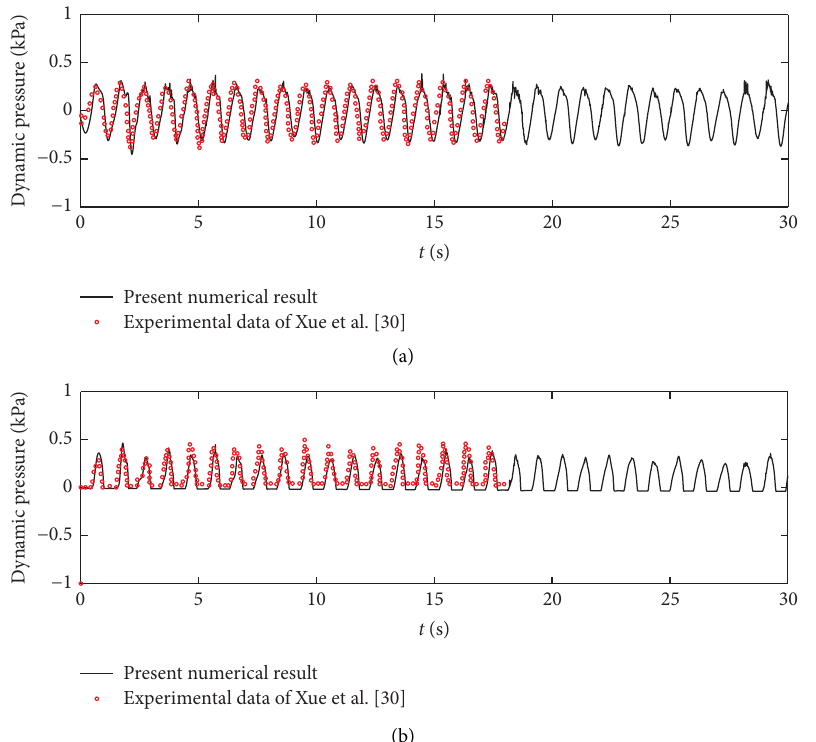
Figure 4: Comparison of the dynamic pressures at P1 (a) and P2 (b) in the tank with a vertical baffle between the present numerical result (solid line) and the experimental data of Xue et al. [30] (circle).